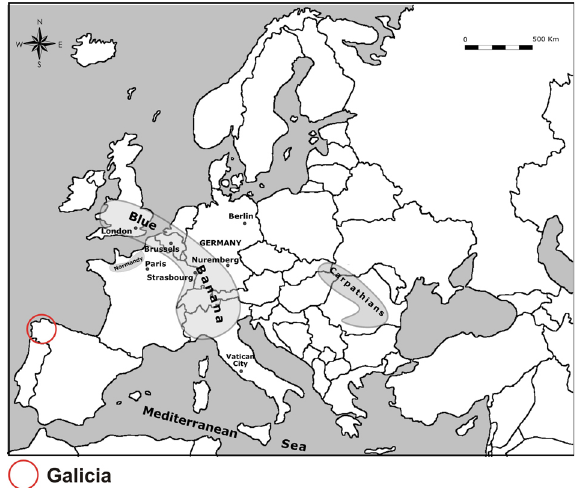
Fig. 4. Political map of Europe showing imaginary spaces after the application of an associated word test on students in training to be primary school teachers. Source: associated word post-test on Europe, University of Santiago de Compostela,